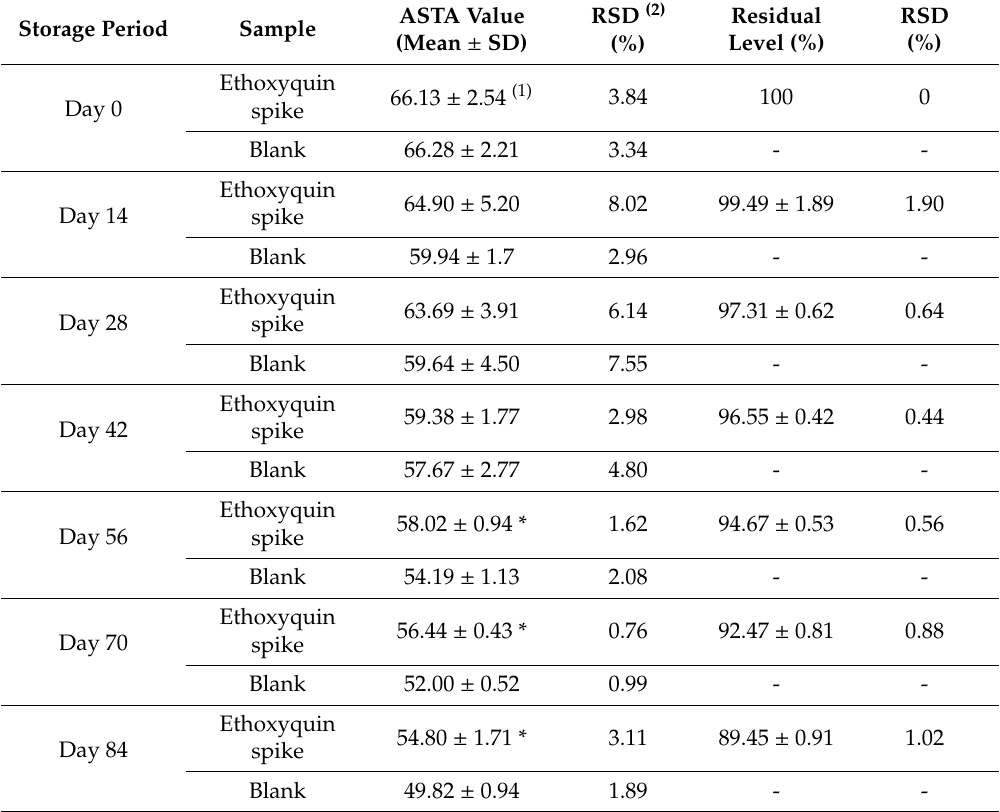
Table 5. Changes of the American Spice Trade Association (ASTA) values and residual level of ethoxyquin in paprika seasoning during